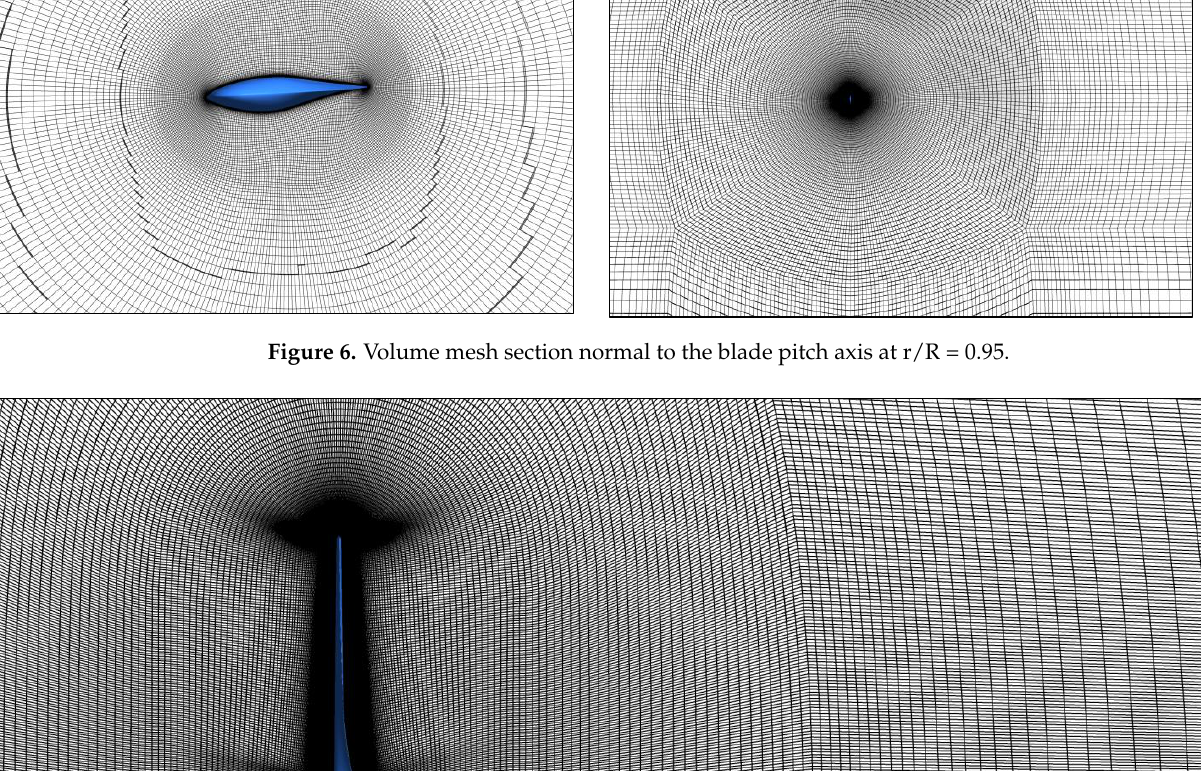
Figure 7. Volume mesh longitudinal section (through rotational axis).